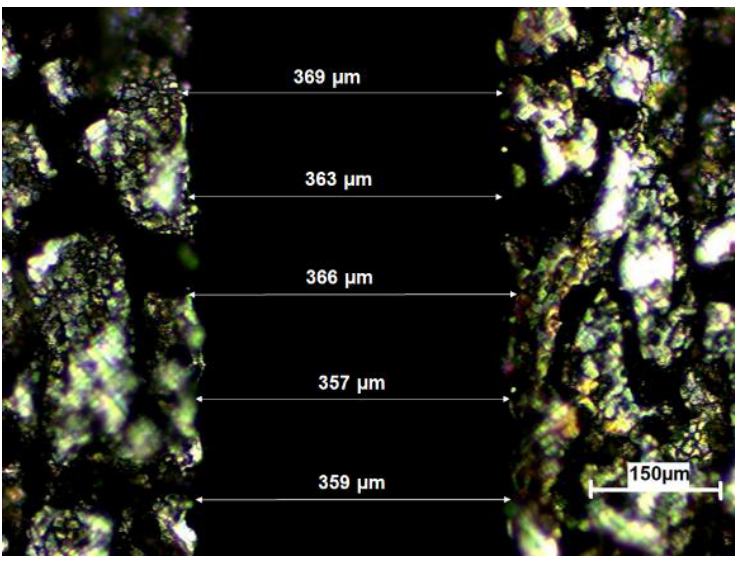
Figure 2. Kerf width measurement using an optical microscope.